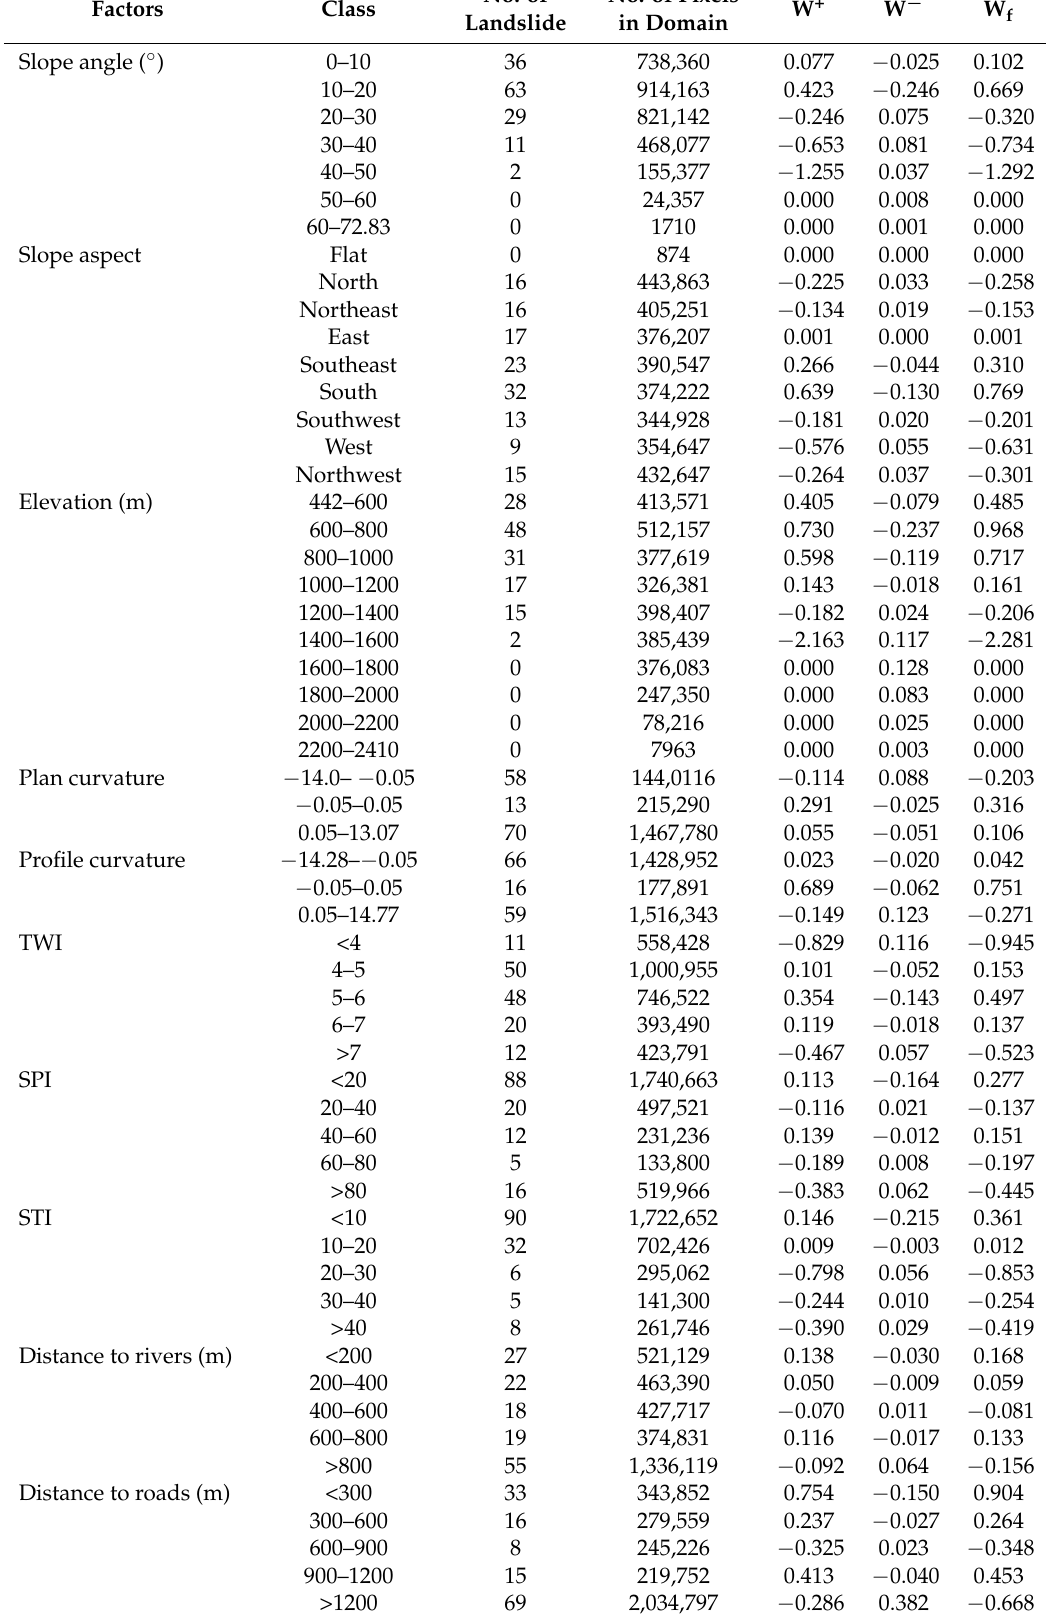
Table 1. Correlation between landslides and conditioning factors using the WoE